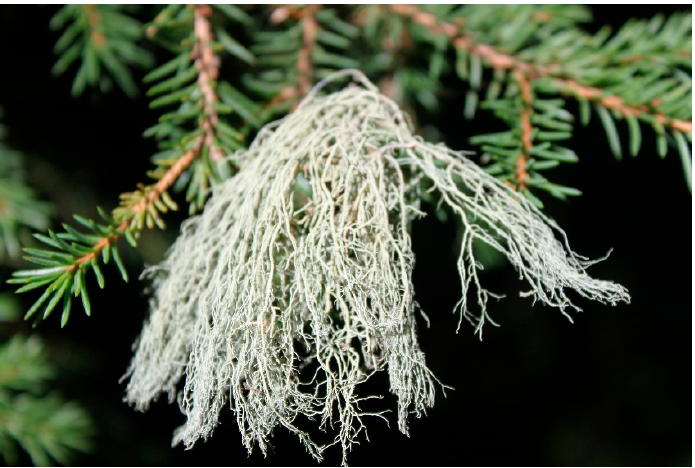
Figure 1. Photograph of Usnea longissima taken at Kanas, Xinjiang, China.